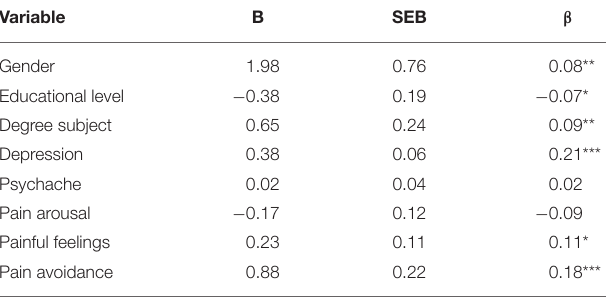
TABLE 2 | Summary of simultaneous multivariate regression results for variables predicting BSI-W scores.